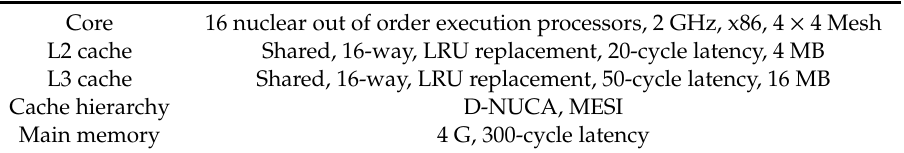
Table 1. System configuration.